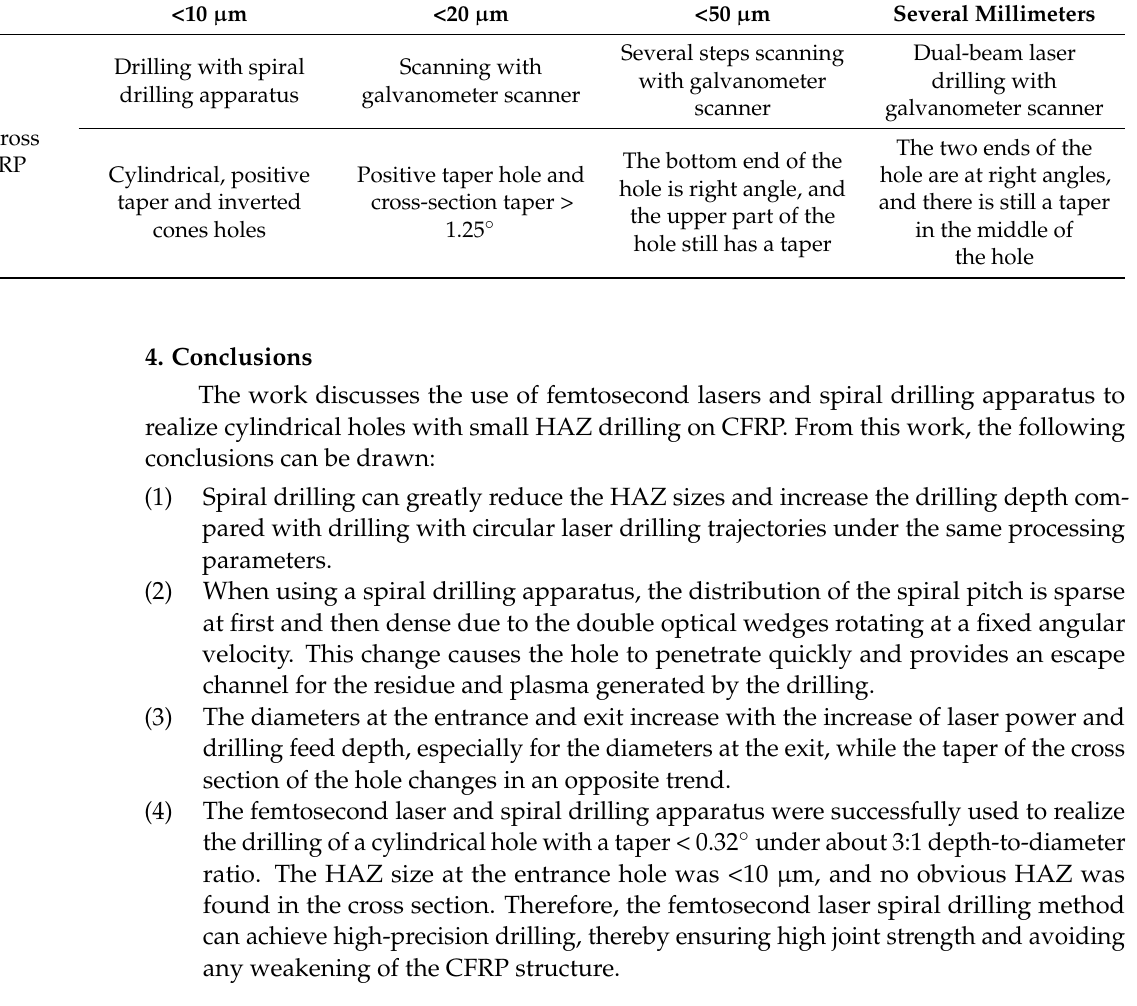
Table 3. Comparison of lasers with different pulse widths on the HAZ and drilling ability of hole cross-section topography with different drilling devices.